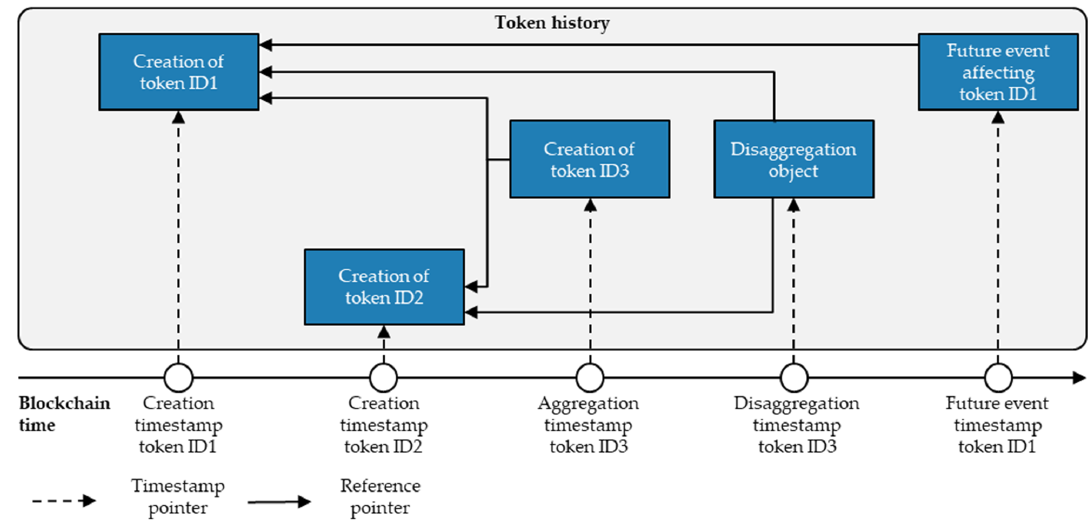
Figure 8. Token event history reference mechanism.